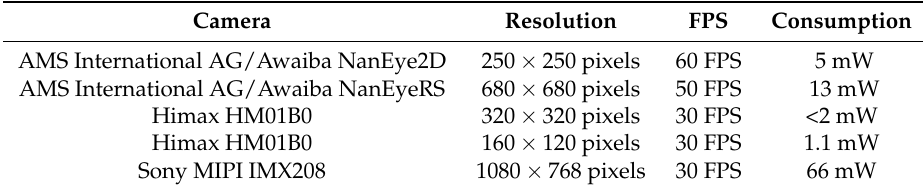
Table 2. EoT supported cameras.